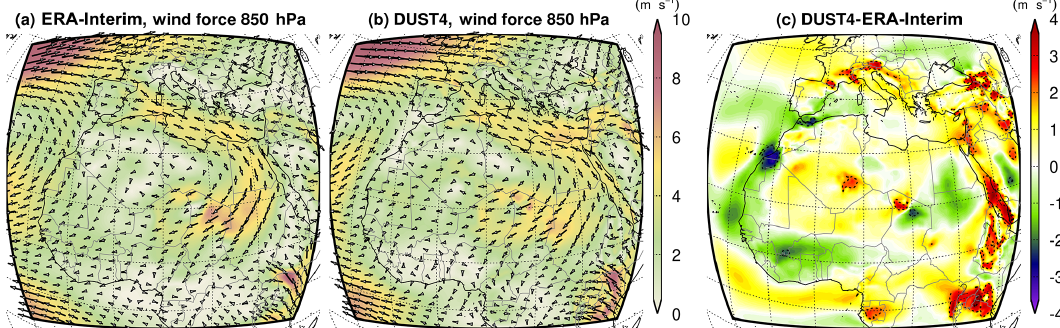
Figure 7. Wind velocity at 850hPa of the DUST4 experiment against the ERA-Interim reanalysis for the period December 2006 to November